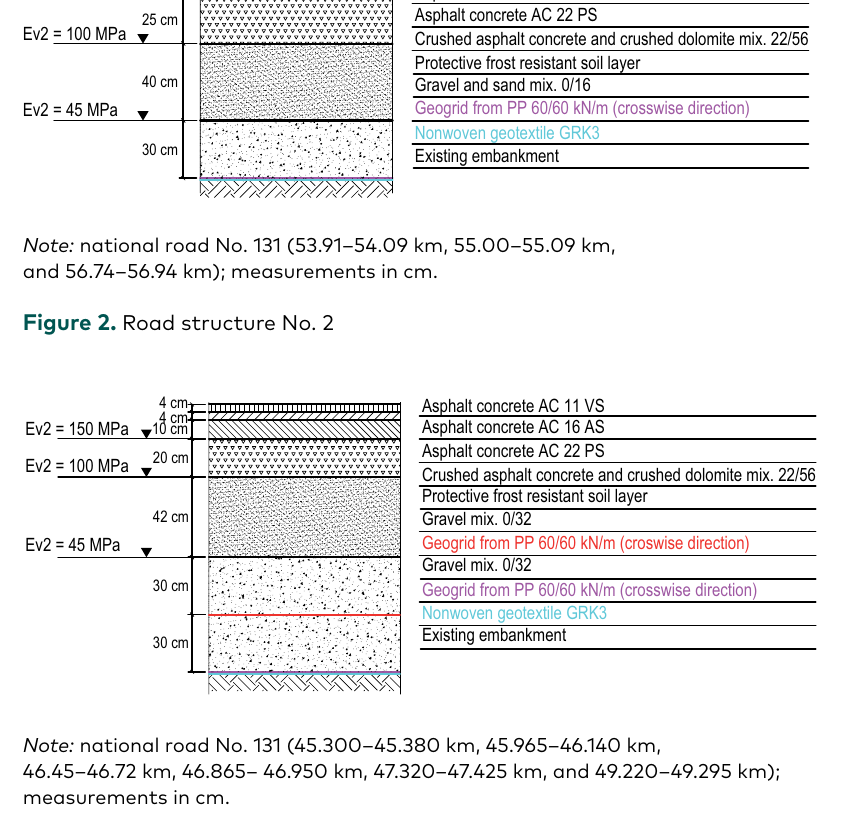
Figure 3. Road structure No. 3